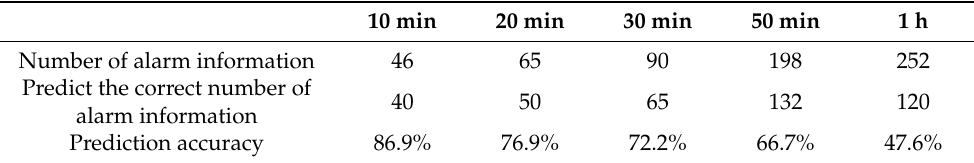
Table 6. Sample diagnosis